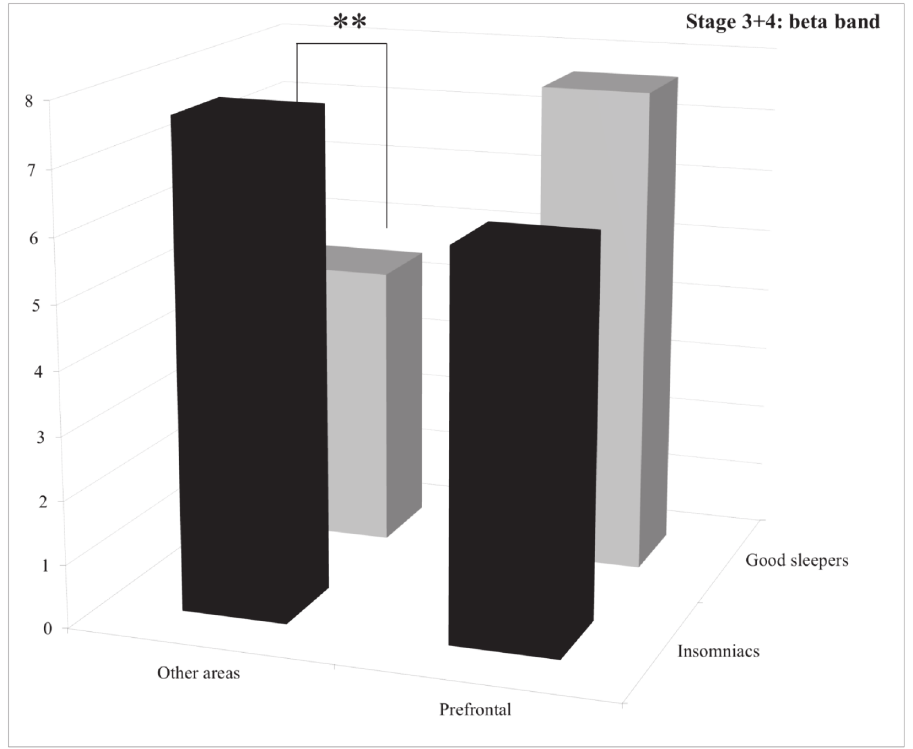
Figure 5. Relative power spectra for the beta band during stage 3+4 for both groups (insomnia patients and good sleepers) and each areas (others vs prefrontal). ** p < 0.05.